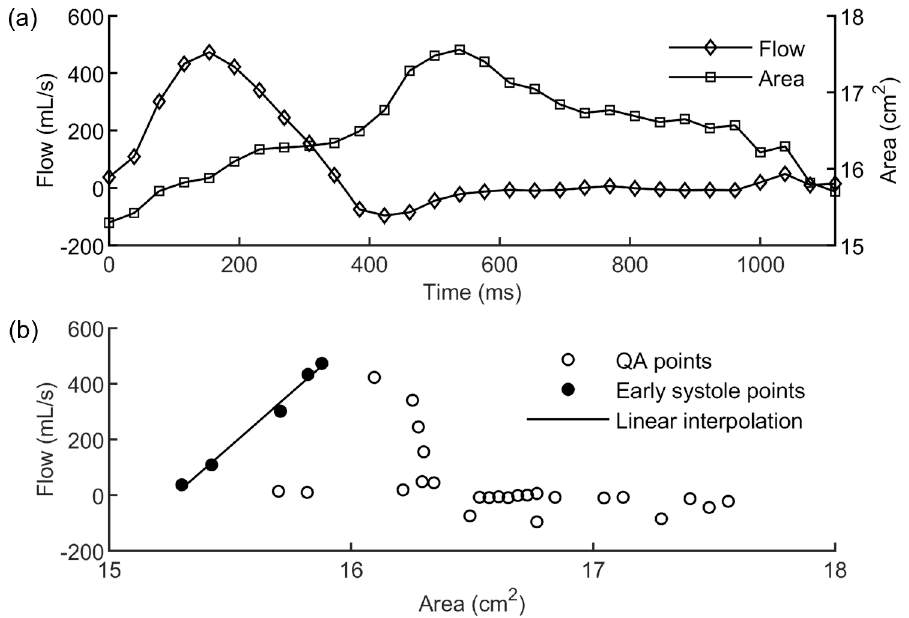
Figure 5. ( a ) Flow and area variations along the cardiac cycle obtained from the segmentation of the patient’s PCMRI data; ( b ) QA loop (white circles) with indication of the points belonging to the early systole period (black circles) used for the linear interpolation (black line) to compute the PWV . Finally, the patient-specific ˆ E of the aortic wall was computed using Equation (2), resulting in 2.02 MPa. Hence, the four quadrature points were equal to 2.42 ( x 1 ), 2.18 ( x 2 ), 1.86 ( x 3 ), and 1.62 ( x 4 ) MPa, according to Table 1, with each value assigned as E of the